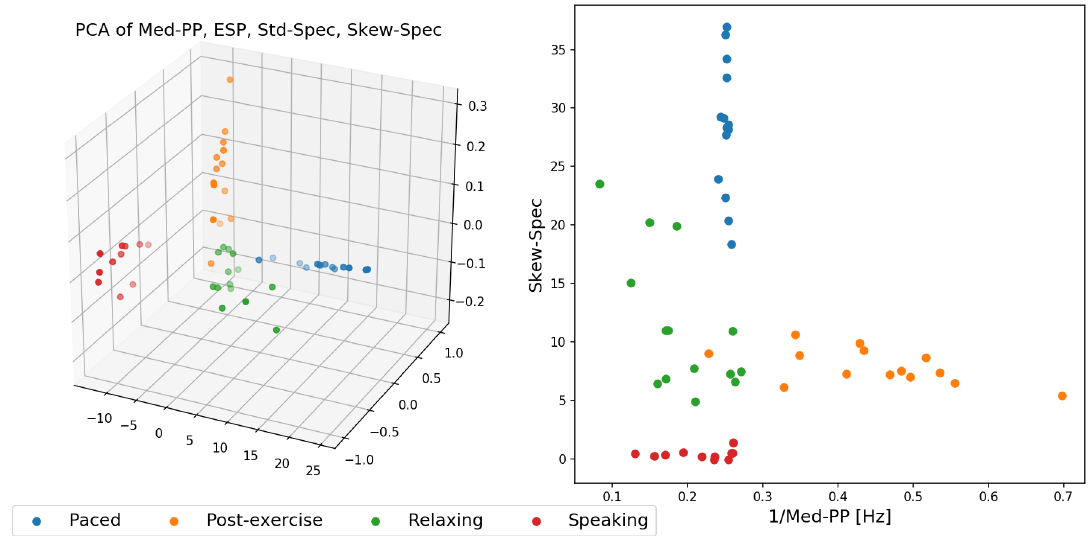
Figure 12. The different activities: paced-breathing meditating, post-exercise recovering, relaxing, and speaking, transformed to feature space. Left : The features Med-PP, ESP, STD-Spec, and Skew-Spec reduced by one dimension by a principal component analysis. Right : The inverse of the feature Med-PP (to express it in Hz) plotted against